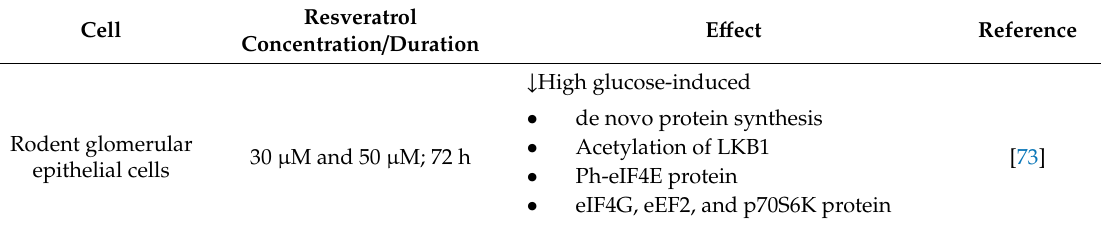
Table 2. E ff ects of resveratrol on renal epithelial